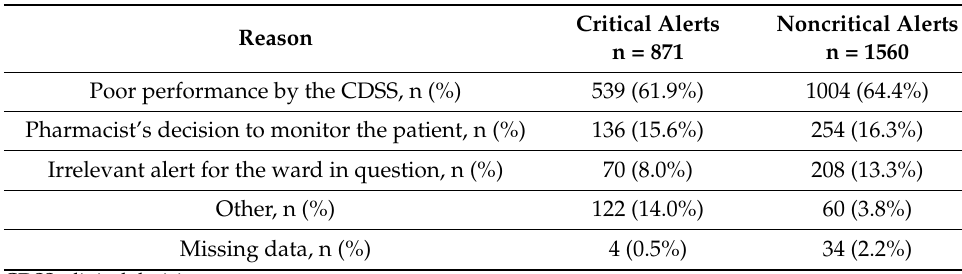
Table 1. Reasons for the pharmaceutical irrelevance of critical and noncritical alerts, according to the clinical pharmacist. Reason